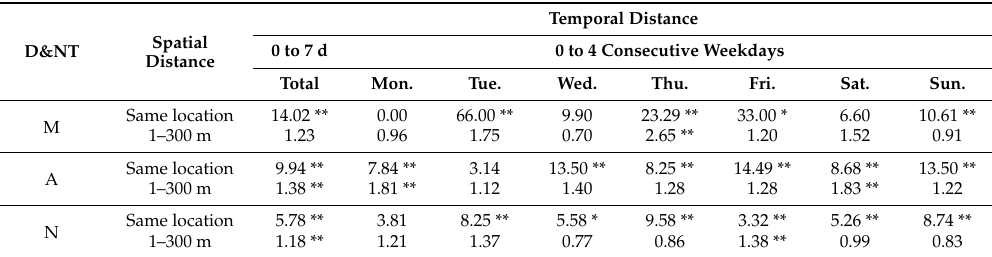
Table 4. Near-repeat risk values (observed over mean expected frequencies) and significance levels of street robbery for the total dataset and weekday and by time of